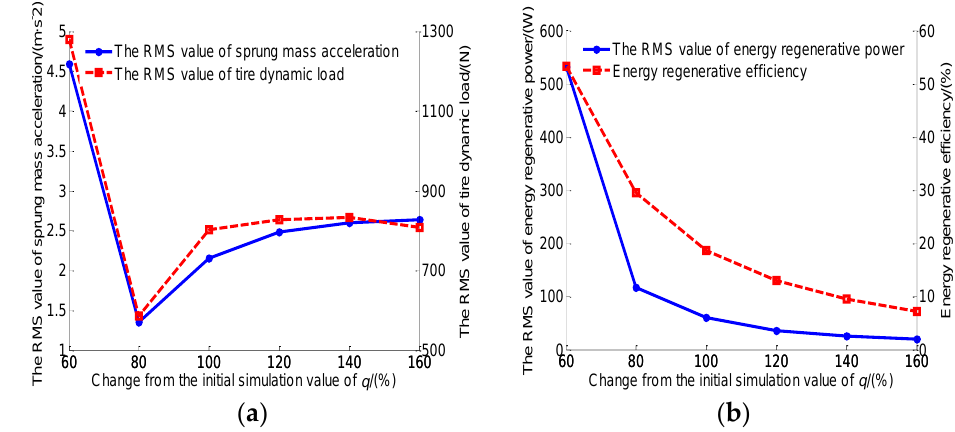
Figure 6. Influence of the effective area of the hydraulic cylinder piston on evaluation indicators: ( a ) Influence of the effective area of the hydraulic cylinder piston on the damping performance; ( b ) Figure 7. Influence of the displacement of the hydraulic motor on evaluation indicators: ( a ) Influence Influence of the effective area of the hydraulic cylinder piston on energy regenerative performance. of the displacement of the hydraulic motor on the damping performance; ( b ) Influence of the displacement of the hydraulic motor on energy regenerative performance.